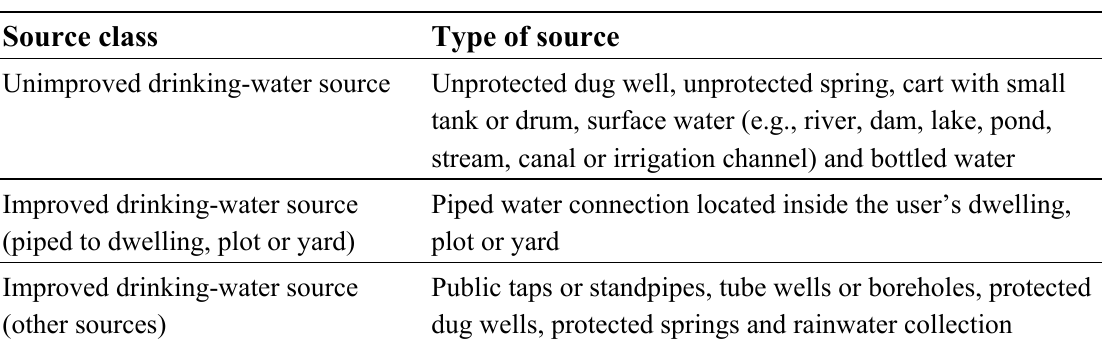
Table 1. JMP Classification of drinking-water source types as improved or unimproved